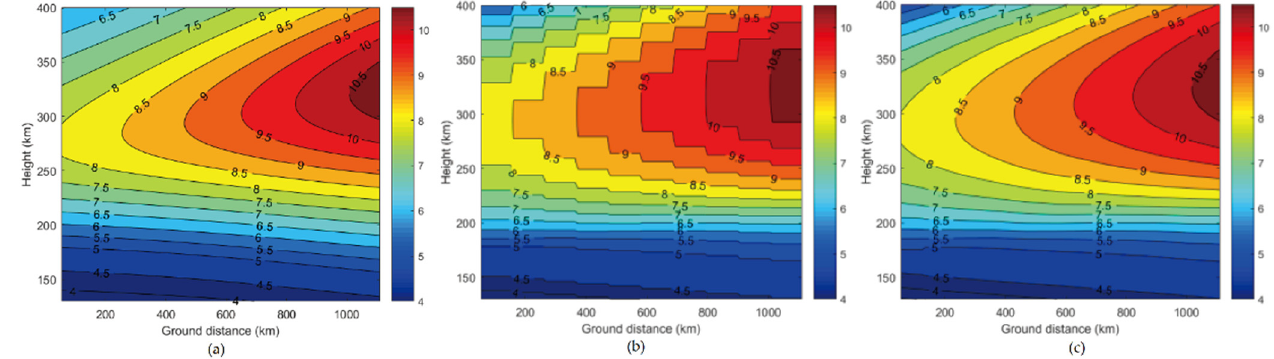
Figure 7. Two-dimensional electron density profile: ( a ) real profile, ( b ) inversion results before fitting and ( c ) inversion results after fitting.